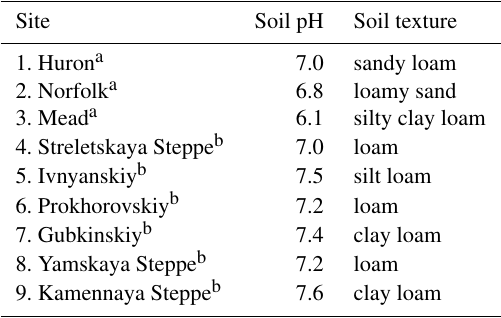
Table 1. Topsoil pH and textures at the nine study sites. Numerals correspond to sites as shown from west to east in Fig.